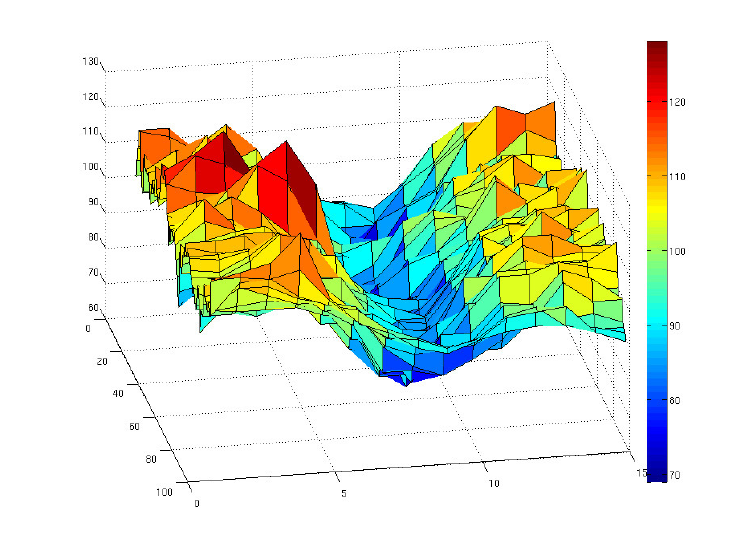
Figure 2. The profile of the trace segment between the two points of Figure